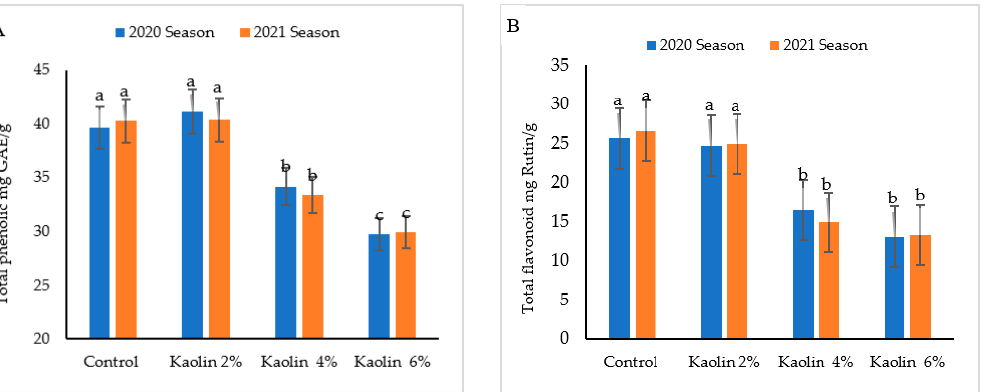
Figure 5. Effect of kaolin spray on: ( A ) leaf total phenolic (mg GAE/g) and ( B ) leaf total flavonoid (mg Rutin/g) of Keitt mango cultivar during the seasons 2020 and 2021. Bars indicate mean values ± SE (n = 9). Different letters above columns indicate significant differences among pruning treatments at p = 0.05 according to Bartlett’s test.